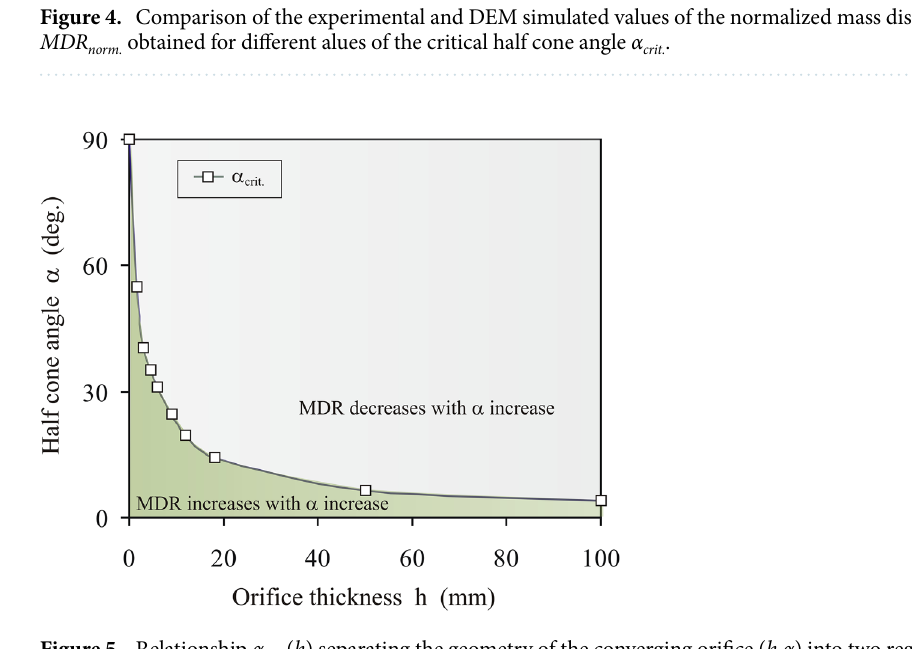
Figure 5. Relationship α crit. ( h ) separating the geometry of the converging orifice ( h,α ) into two regions of increase ( α < α crit. ) and decrease ( α > α crit. ) of the mass discharge rate MDR with α increase determined for d 0 = 32.5